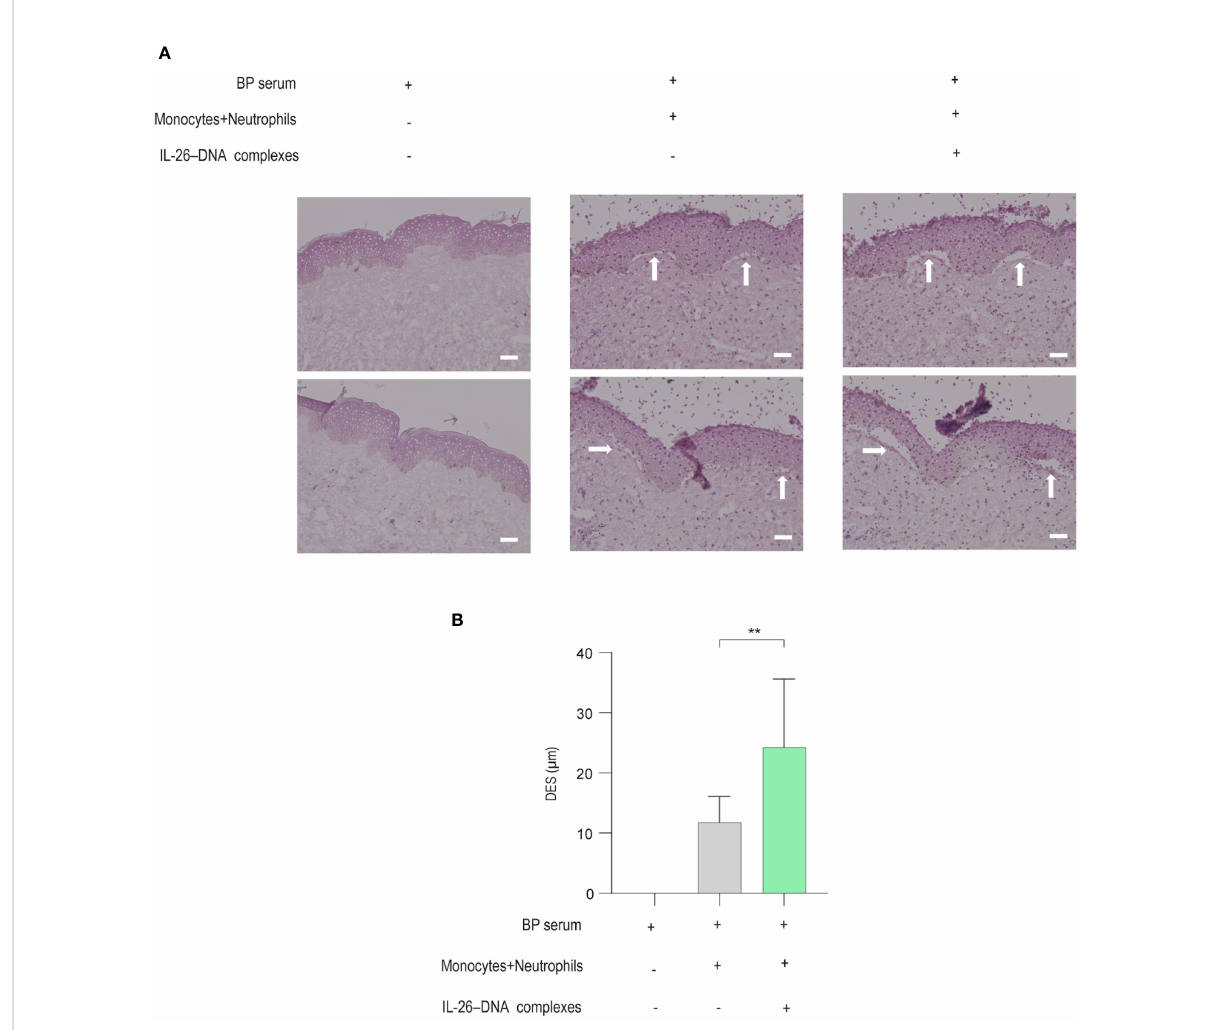
FIGURE 7 Effects of monocytes and neutrophils stimulated with IL-26 – DNA complexes in an ex vivo BP skin model (A) Representative images showing DES (white arrows) on cryosections in the presence of BP serum incubated with/without monocytes and neutrophils stimulated with/without IL- 26 – DNA complexes. (B) DES lengths measured on cryosections. Data are presented as mean ± SD. ** p <